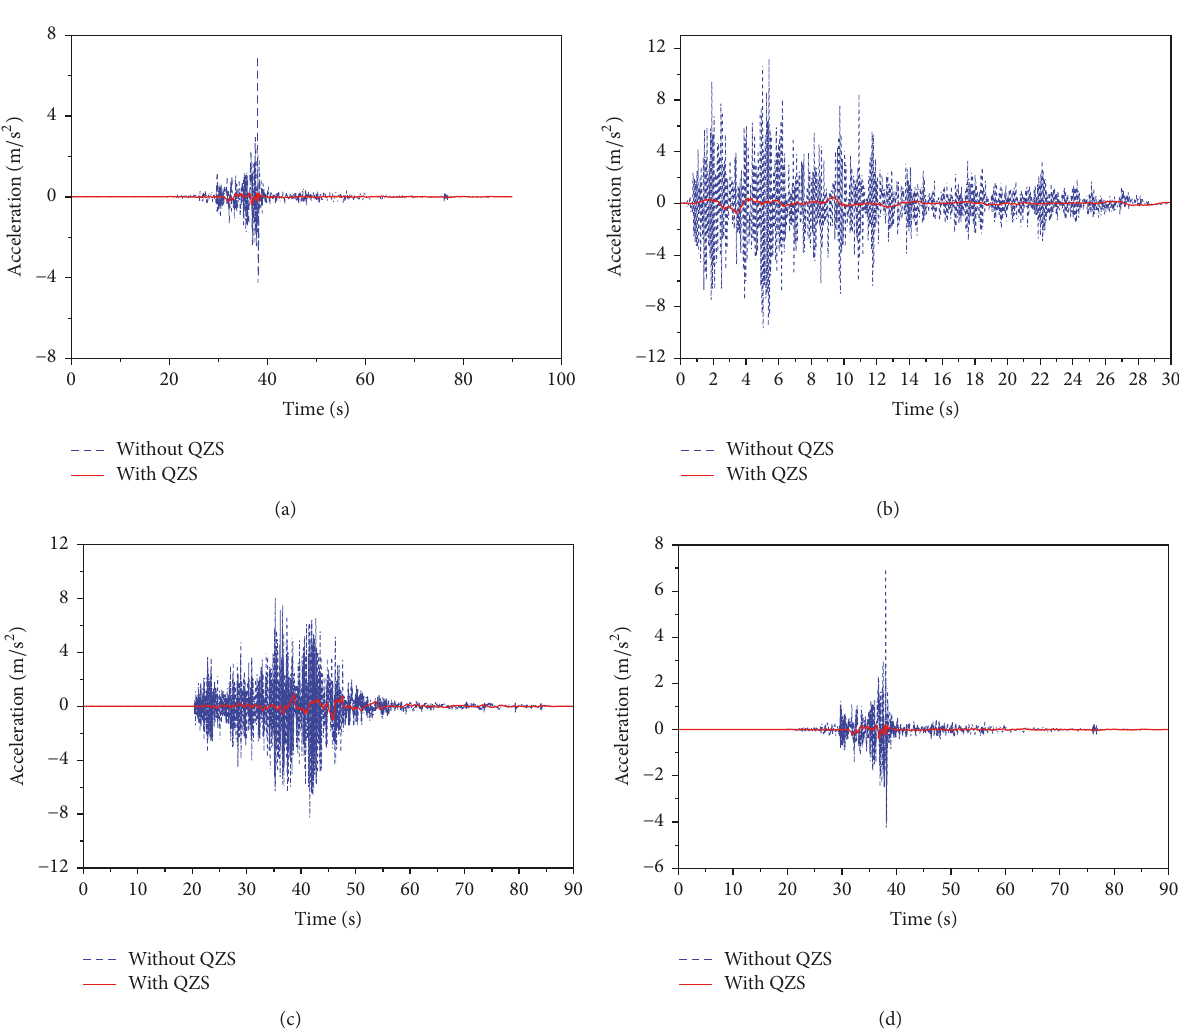
Figure 12: Comparison of ACCs for the QZS system and the seismic isolated system without QZS: (a) Loma Prieta-Saratoga-Aloha Ave.; (b) Kocaeli-Izmit; (c) Chi-Chi-TCU089; (d)